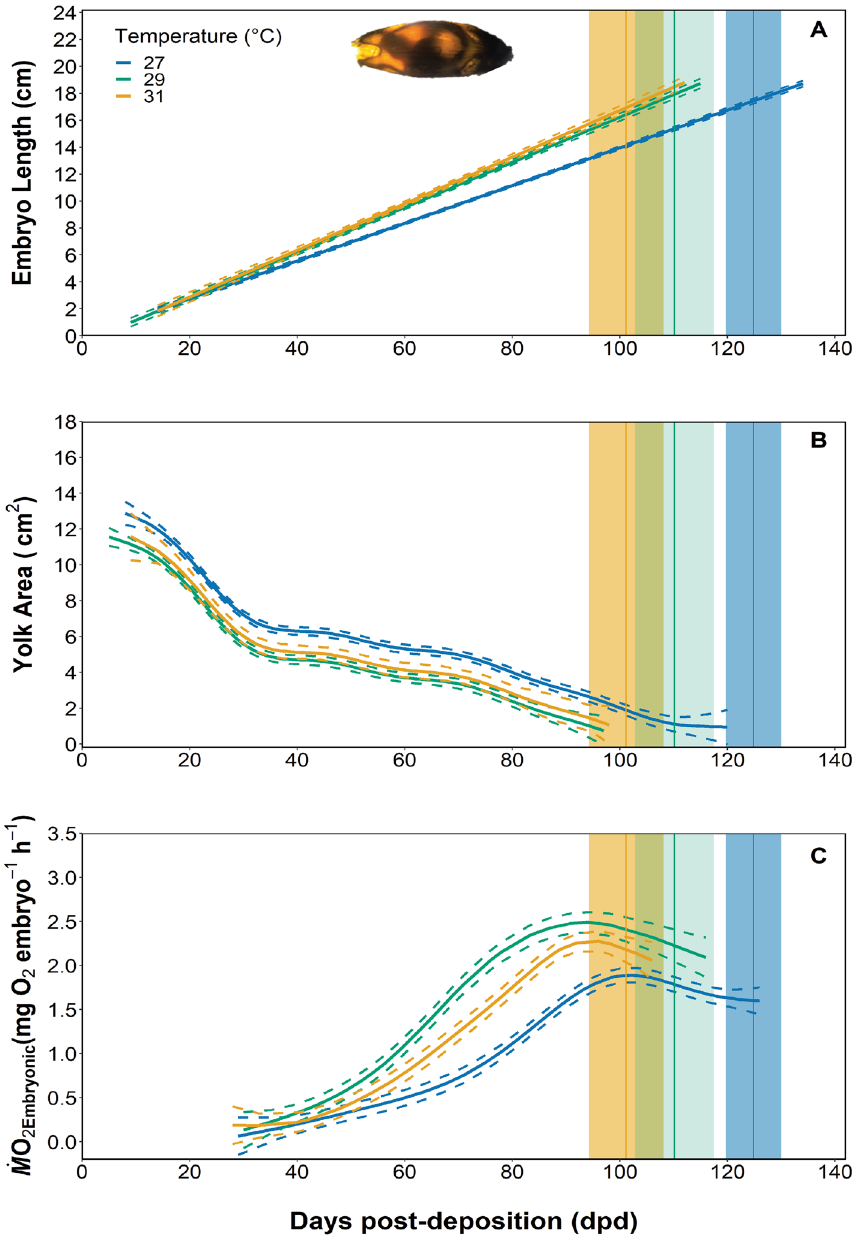
Figure 1. The growth rate (cm day −1 ) ( A ), yolk-sac consumption rate (cm 2 day −1 ) ( B ), and embryonic oxygen uptake (mg O 2 embryo h −1) ( C ), over the in ovo incubation period at 27, 29, and 31 °C. The embryonic length data were fit using a mixed linear model (S1A), and yolk-sac consumption and RMR were fit with a generalized additive model (GAM) (S1B,C). Model fits are represented by solid lines, and 95% confidence intervals are represented by dashed lines. Model fits were considered significant at α = 0.05. The vertical lines represent the mean incubation time at each temperature treatment, and the shaded boxes represent the standard error around the